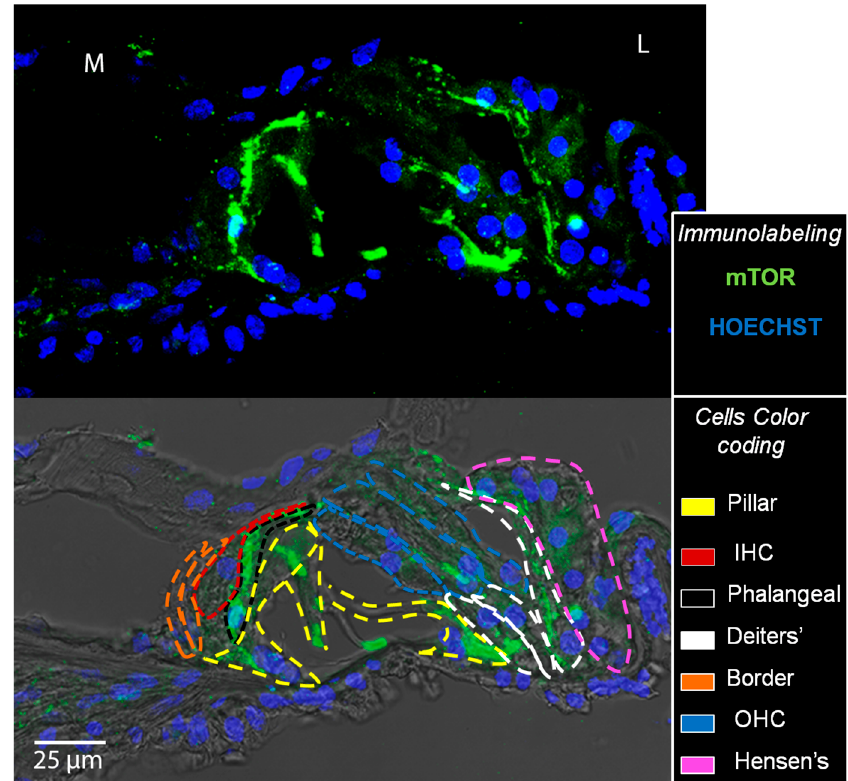
Figure 9. Immunolocalization of the mTOR protein. Top: a representative confocal image of the organ of Corti of a NH cochlea (A1 location) immunolabelled with anti-mTOR (green) and counterstained with bisbenzimide nuclear dye (blue). Bottom: The same image was acquired with a bright-field background to visualize the structure of the organ of Corti; the different cell types were signed with color coding (pillar: yellow, IHC: red, phalangeal: black, Deiters’: white, border: orange, OHC: blue, Hensen’s: pink). L: lateral, M: medial. Accordingly, PTEN protein levels (Figure 13) were not different between the groups ( p = 0.43, statistical analysis: Kruskal–Wallis, n = 5), and a high variability was found between the NH samples (Figure